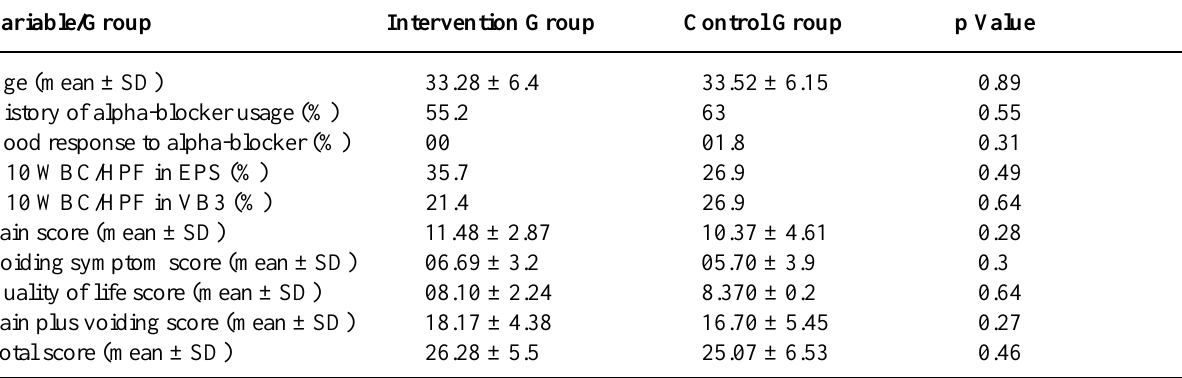
Table 1 – Comparison of underlying variables between 2 groups (intervention and control) before treatment.